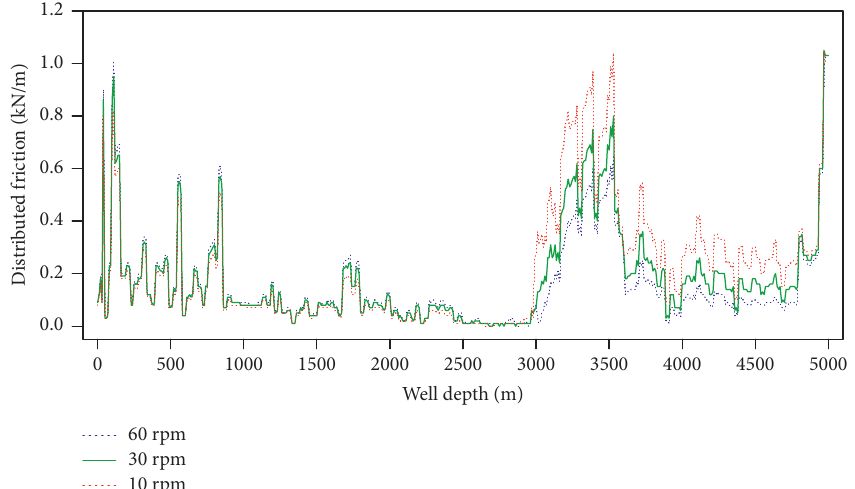
Figure 13: Effect of rotational speed on friction.